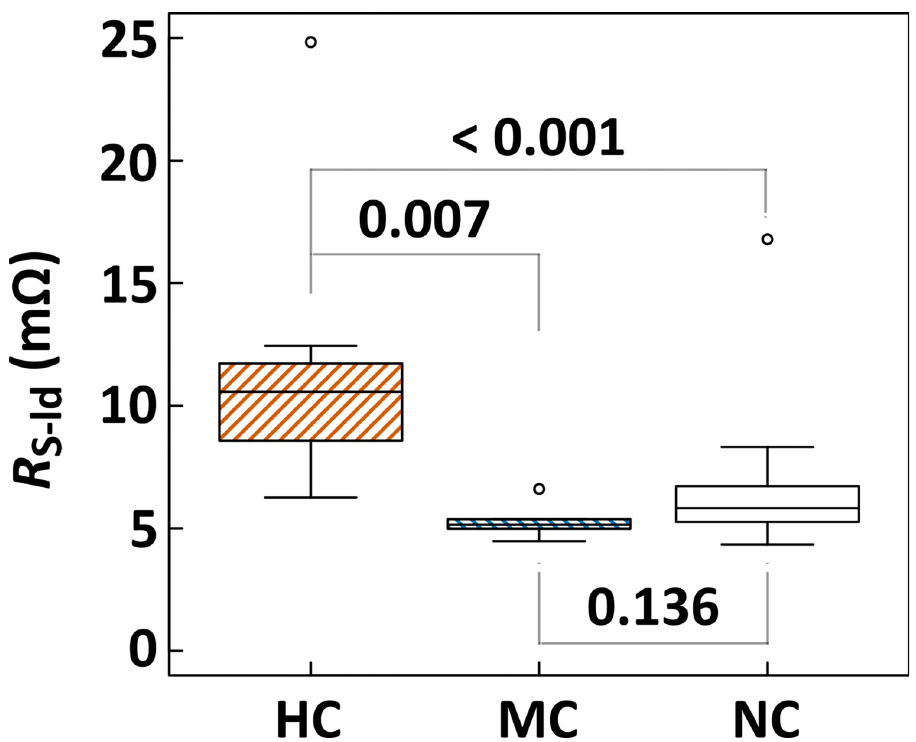
Fig 11. Multicomparison results for all categorized PV cells on R s-ld . Respective p -values are also indicated. The open circles express outliers.